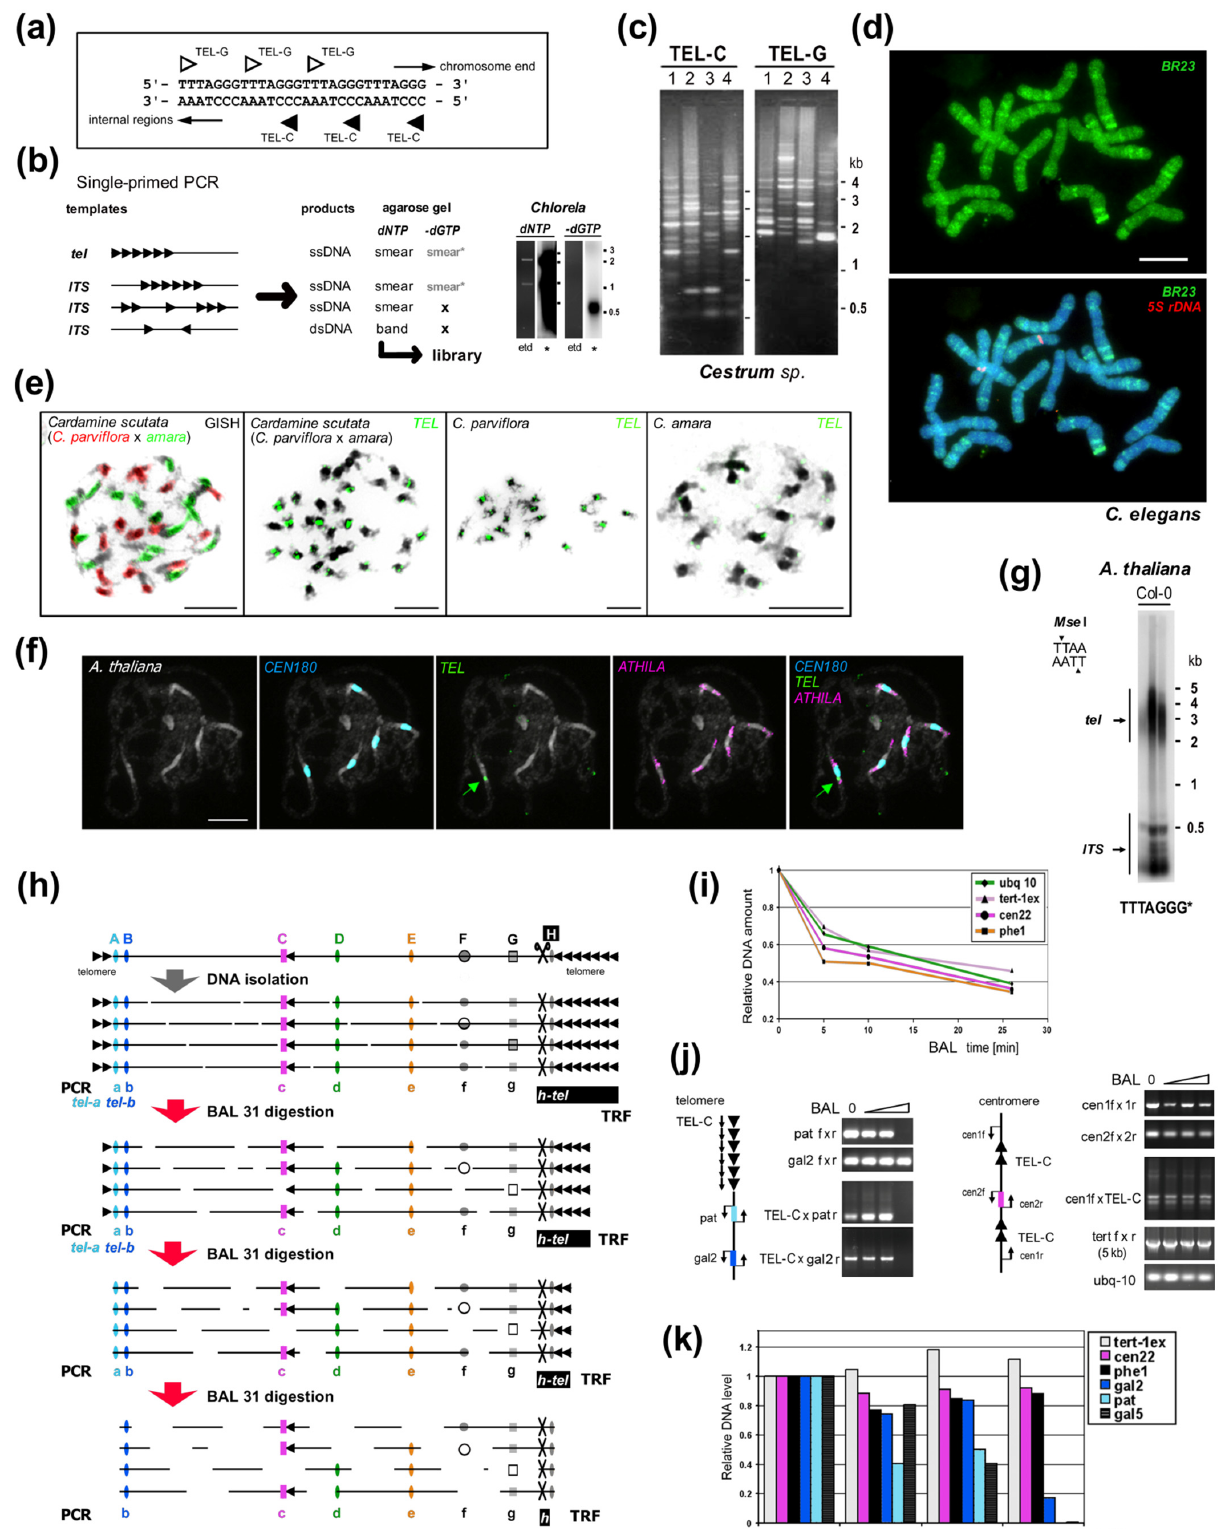
Figure 2. Experimental examination of ITS and telomeric repeats. ( a ) Telomere repeats are strand oriented. ( b ) Telomere-like repeats in telomeres or internal sites may form clusters or short stretches. Single-primed PCR distinguishes between these using an extension reaction with a single telomeric oligonucleotide primer (C-rich primer is shown,